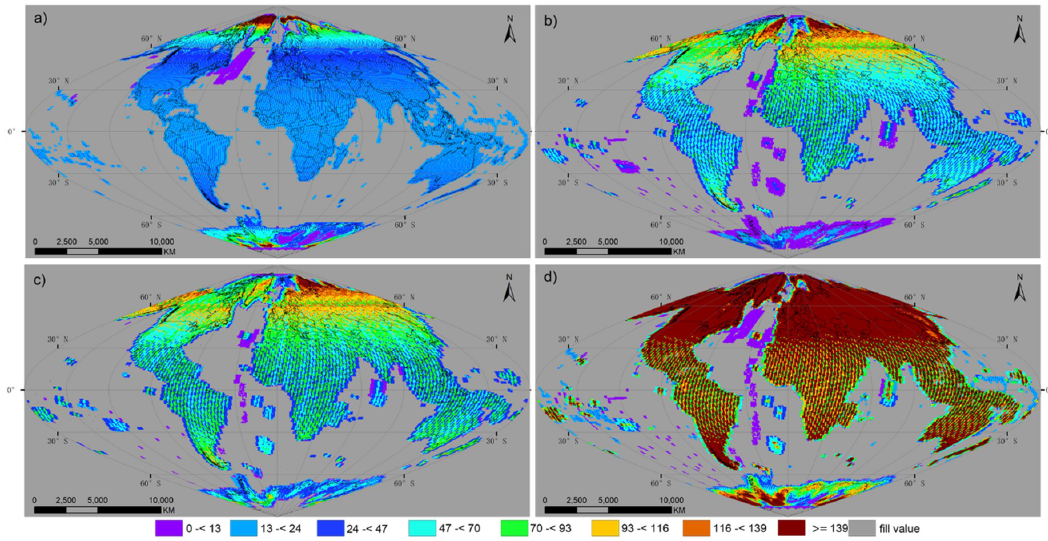
Figure 3. Average number of satellite observations over each land grid point from 1 January to 31 December 2018 by ( a ) Landsat‐8, ( b ) Sentinel‐2A, ( c ) Sentinel‐2B, and ( d ) three sensors combined. The results were examined on a global grid, defined by an equal area sinusoidal projection, composed of 7201 × 3601 grid points, with a spacing of 0.05°.